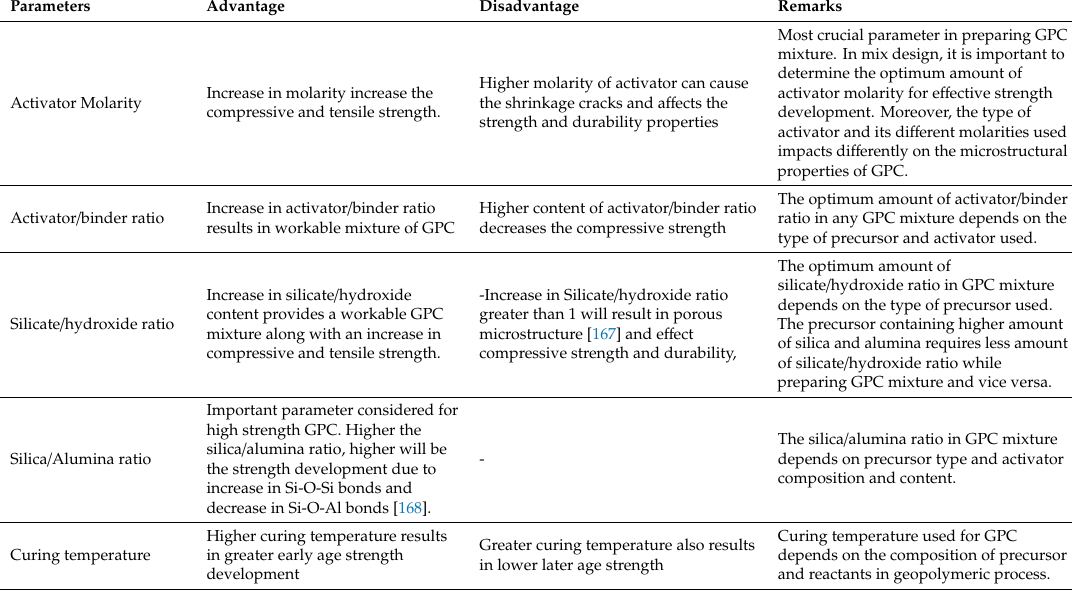
Table 9. Pros and cons of di ff erent parameters considered for GPC.